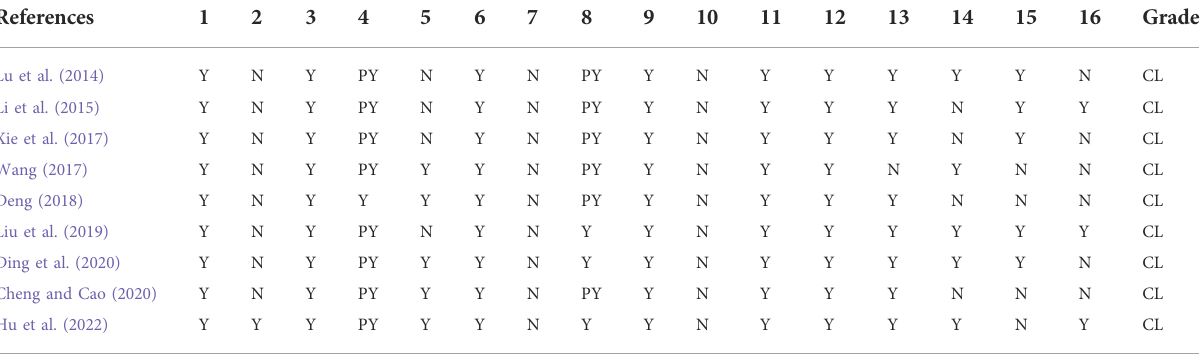
TABLE 2 AMSTAR 2.0